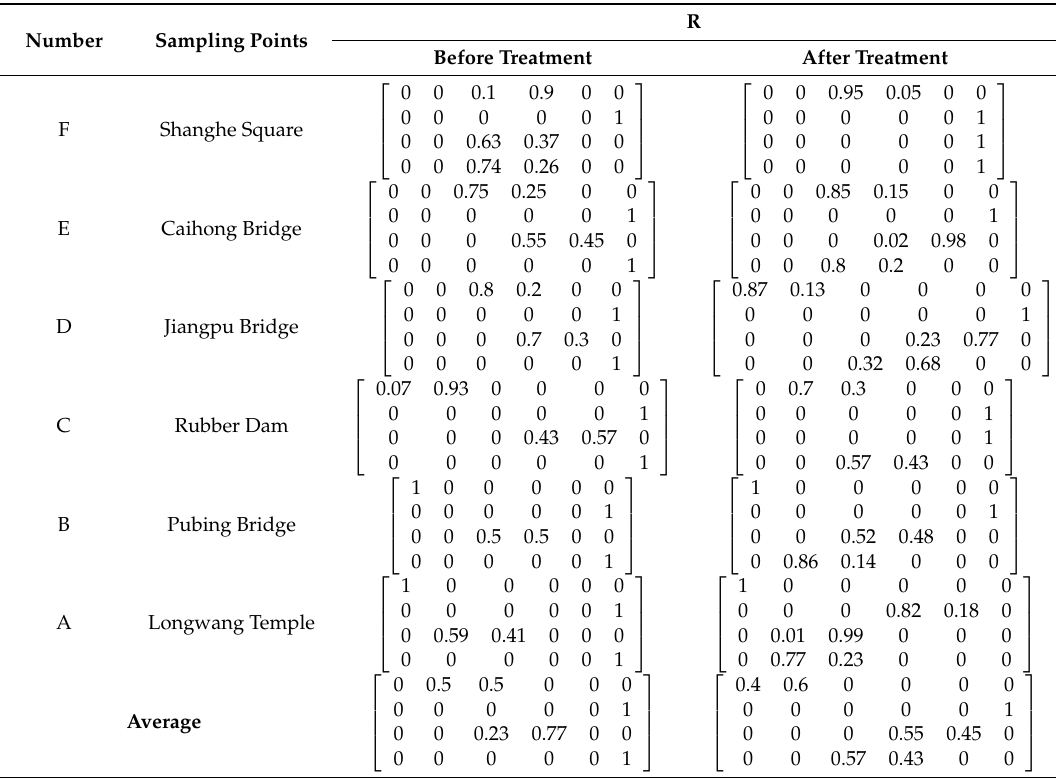
Table 11. The fuzzy relation matrix R of the six monitoring